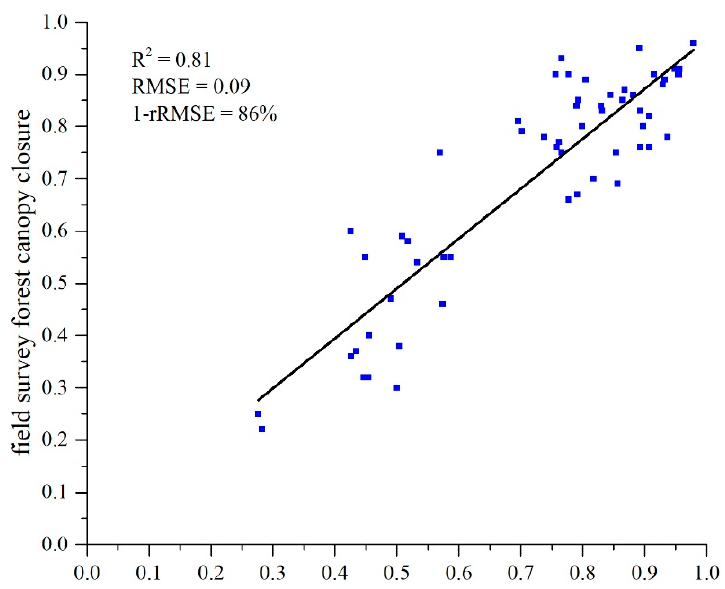
Figure 7. Accuracy Assessment for the canopy closure prediction using Landsat 8 satellite images.